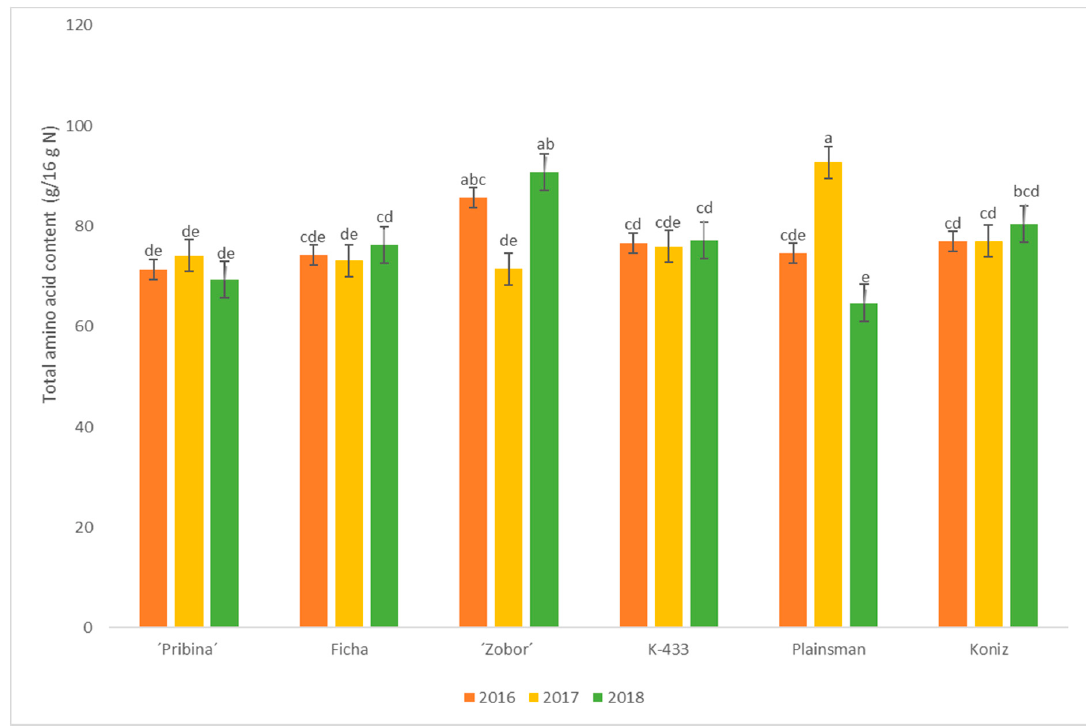
Figure 2. Total amino acid content (g/16 g N) in amaranth seed samples for three cropping seasons (2016–2018). Results are the means (± SE; standard error) for three seasons of three independent biological replicates per each variety per year. Different letters on bars indicate significant differences by the Tukey test ( p ≤ 0.05).